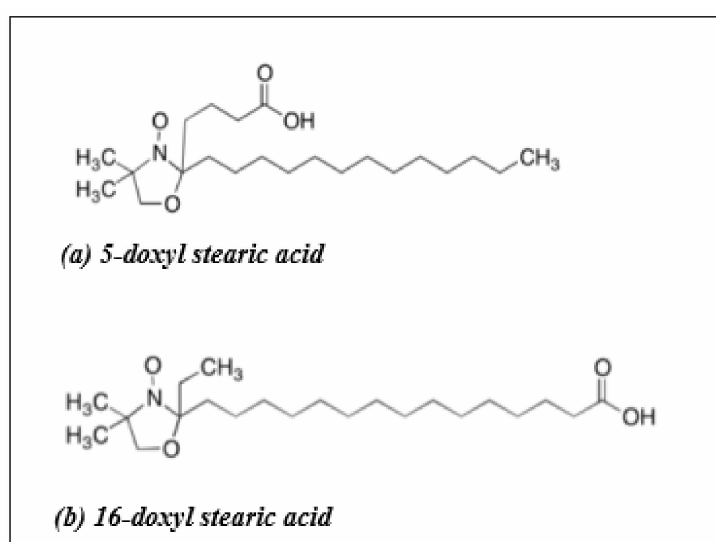
Figure 2. Molecular structures of 5-doxyl stearic acid and 16-doxyl stearic acid